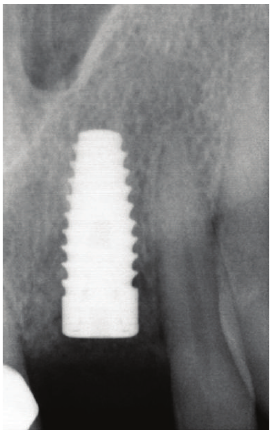
Figure 9: Radiographical control at 2-year